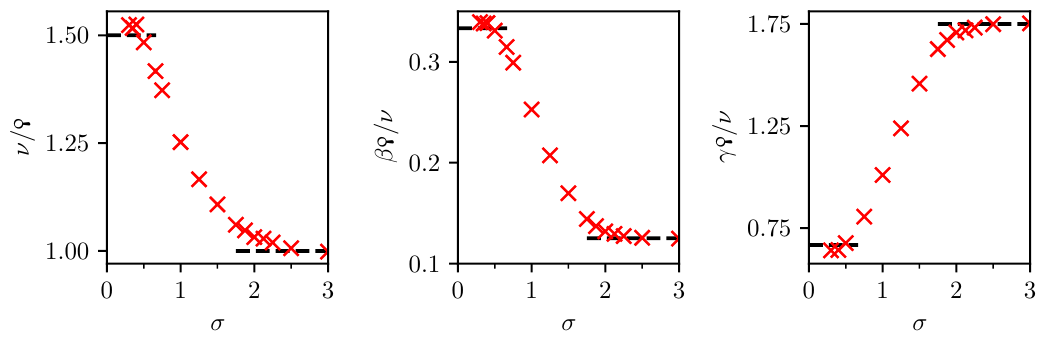
Figure 1: Exponents extracted by data collapses of the SSE data as a function of the decay parameter σ . The field-theoretical predictions in the long-range mean- field regime with σ < 2 / 3 (see Tab. 3: ν/ ϙ = 3 / 2, β ϙ /ν = 1 / 3, γ ϙ /ν = 2 / 3) as well as the well-known 2d Ising critical exponents in the short-range regime σ > 2 (see Tab. 3: ν/ ϙ = 1, β ϙ /ν = 1 / 2, γ ϙ /ν = 1) are depicted by black dashed lines. [ 53 ] is not reflected in The expected shift of the short-range regime to σ > 2 − η SR the exponents due to a rounding at the boundary. The raw data used to extract the exponents and the numerical values of the exponents are provided in Ref. [ 71 ]